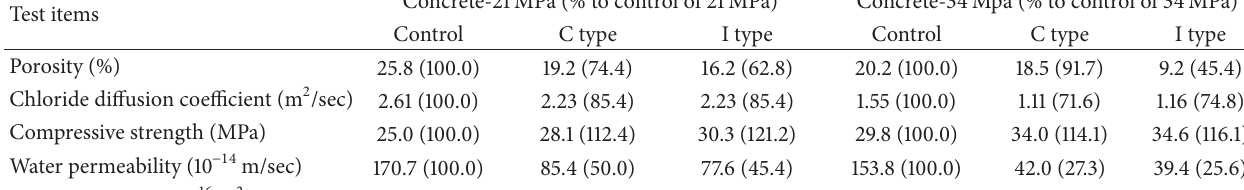
Table 5: Summary of modified properties tests.